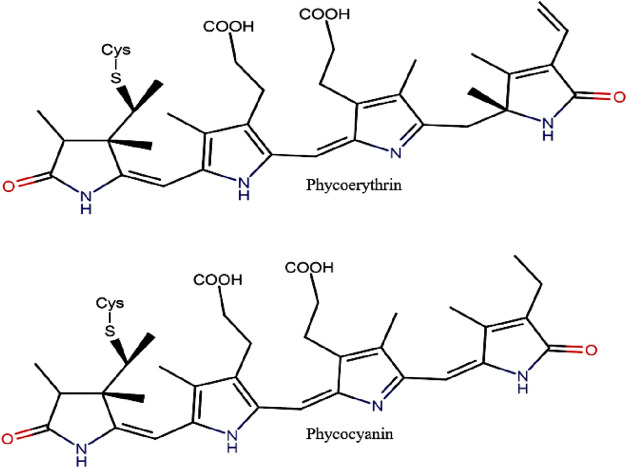
Chemical structure of PE and PC (adapted from Wilk et al., 1999; Hoseini et al., 2013).